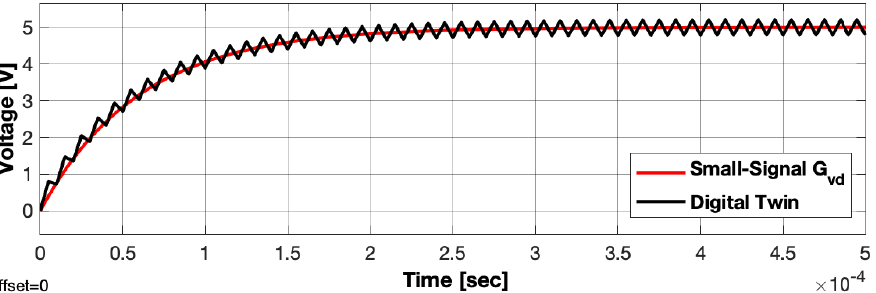
Figure 12. Dynamic feature comparison between the small-signal G vd transfer function and the Simulink digital twin